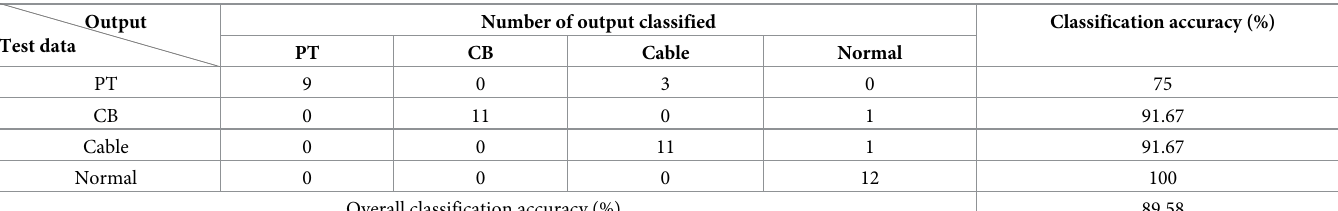
Table 3. Classification results using SVM based on 70:30 ratio for training and testing.